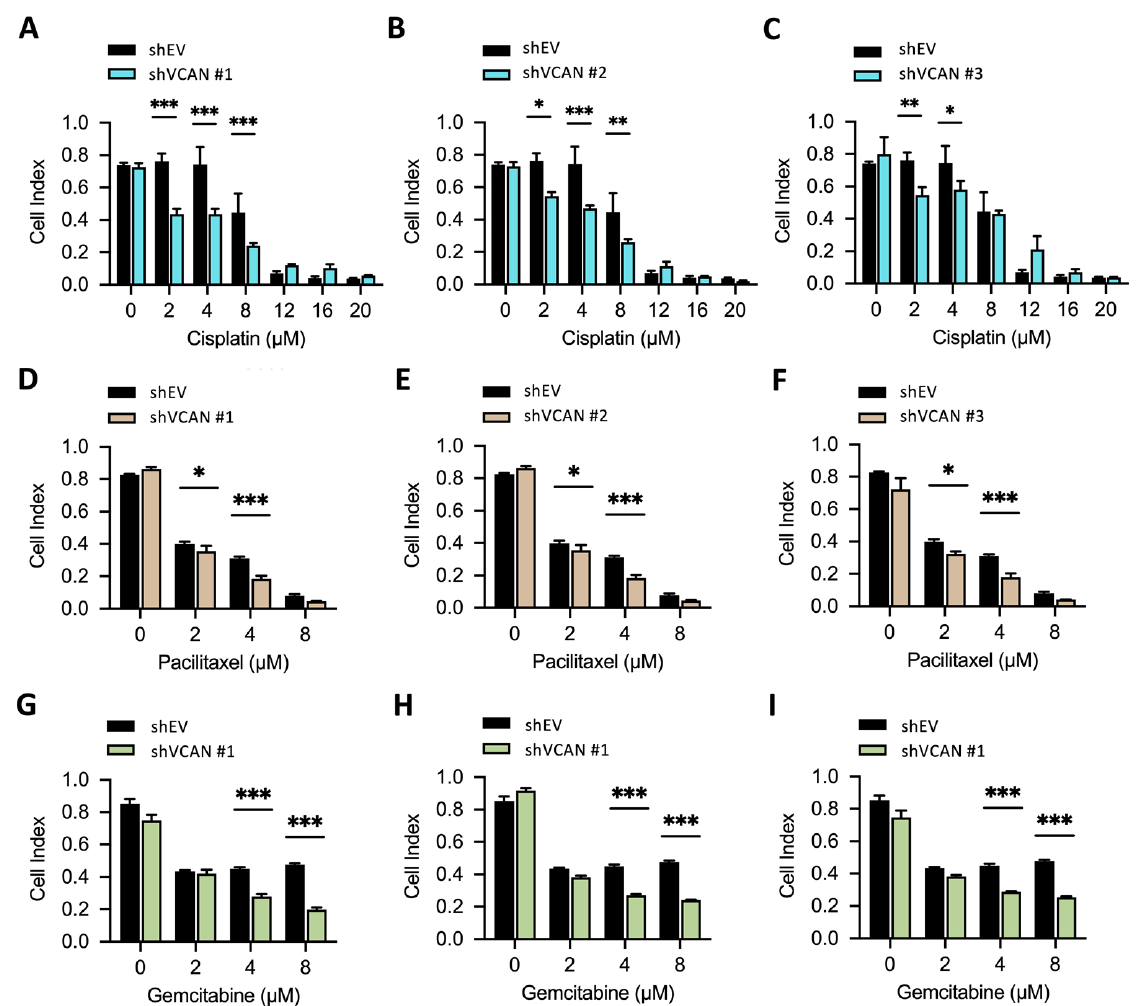
Figure 7. Silencing of VCAN increased drug sensitivity in UTUC. ( A – I ) BFTC909-shEV, shVCAN#1, shVCAN#2 and shVCAN#3 cells were treated with different concentrations of the drugs for 3 days, and the cell viability was then determined using the WST-1 assay. The data are presented as mean ± SD, and statistical analysis was performed using a two-way ANOVA with Sidak’s multiple comparisons test. * p < 0.05; ** p < 0.01; *** p < 0.001.